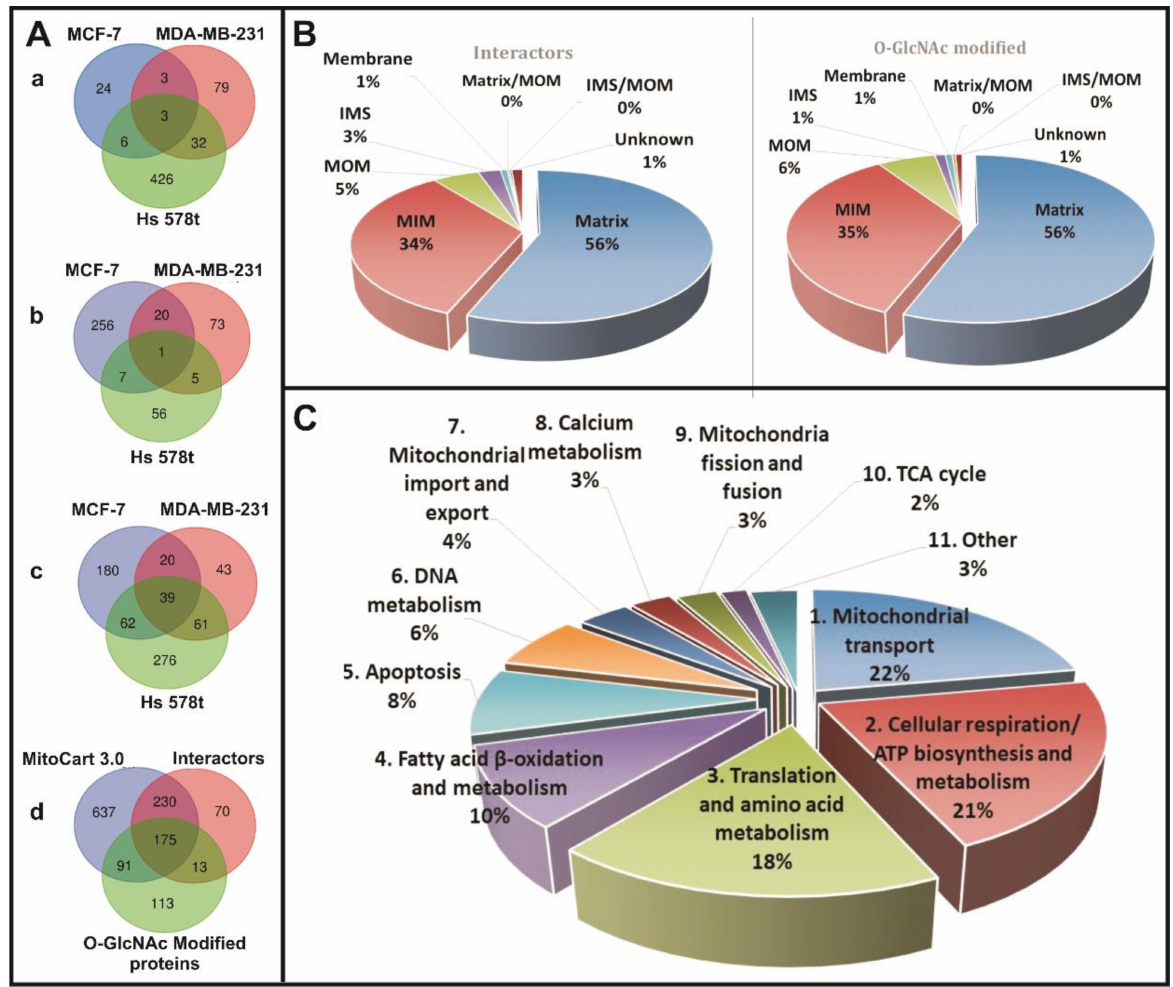
Figure 5. Proteomic analysis of isolated mOGT interactors and O -GlcNAc-modified candidates from mitochondria-enriched lysates of three analyzed cell lines. ( A ) Venn diagrams showing a, the total number of identified mOGT mitochondrial interactors; b, the total number of identified mOGT modified mitochondrial candidates; c, the total number of all identified mOGT protein partners and substrates; d, the interactors and O -GlcNAcylated candidates common with mitochondrial proteins according to MitoCart 3.0 datasets (Broad Institute). ( B ) The graph presents submitochondrial localization of identified interactors and O -GlcNAc modified candidates according to MitoCart 3.0 datasets. ( C ) The graph presents identified mitochondrial mOGT candidate proteins distributed into biological functional classes. MOM, mitochondrial outer membrane; IMS, intermembrane space; MIM, mitochondria inner